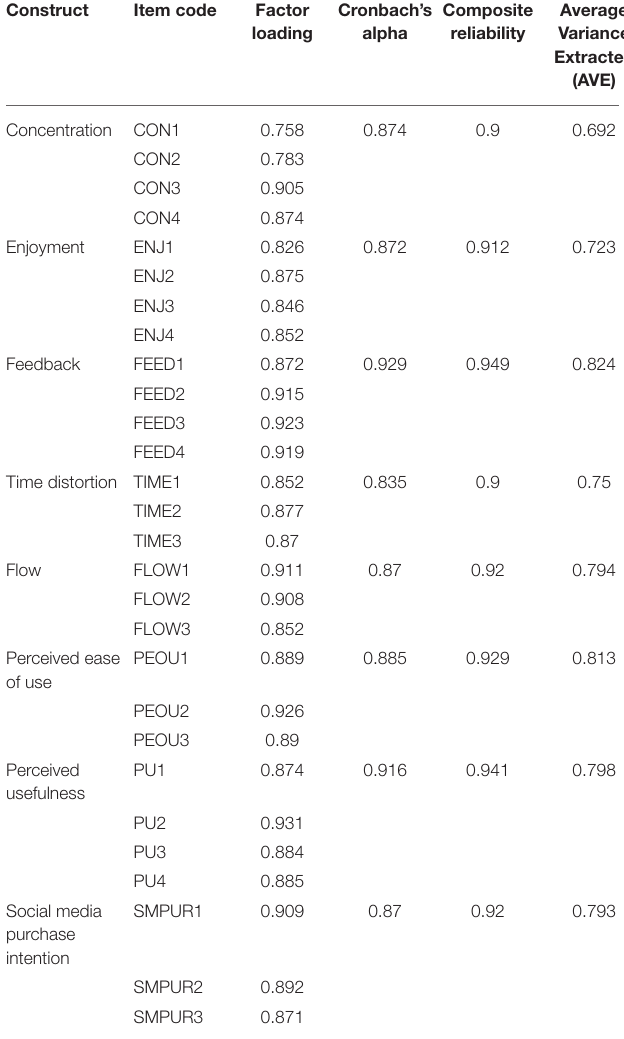
TABLE 1 | Convergent